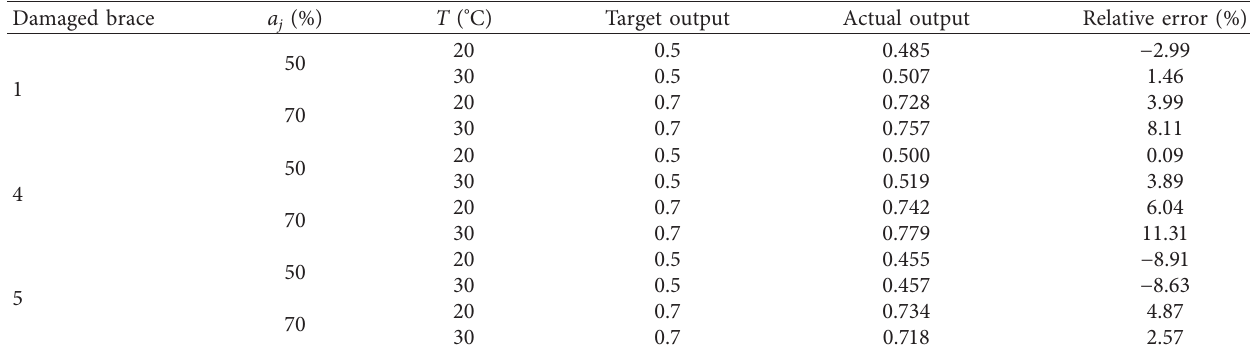
The target results of networks are shown in parentheses. Table 4: The identification results of damage severities when one brace is damaged. Damaged brace